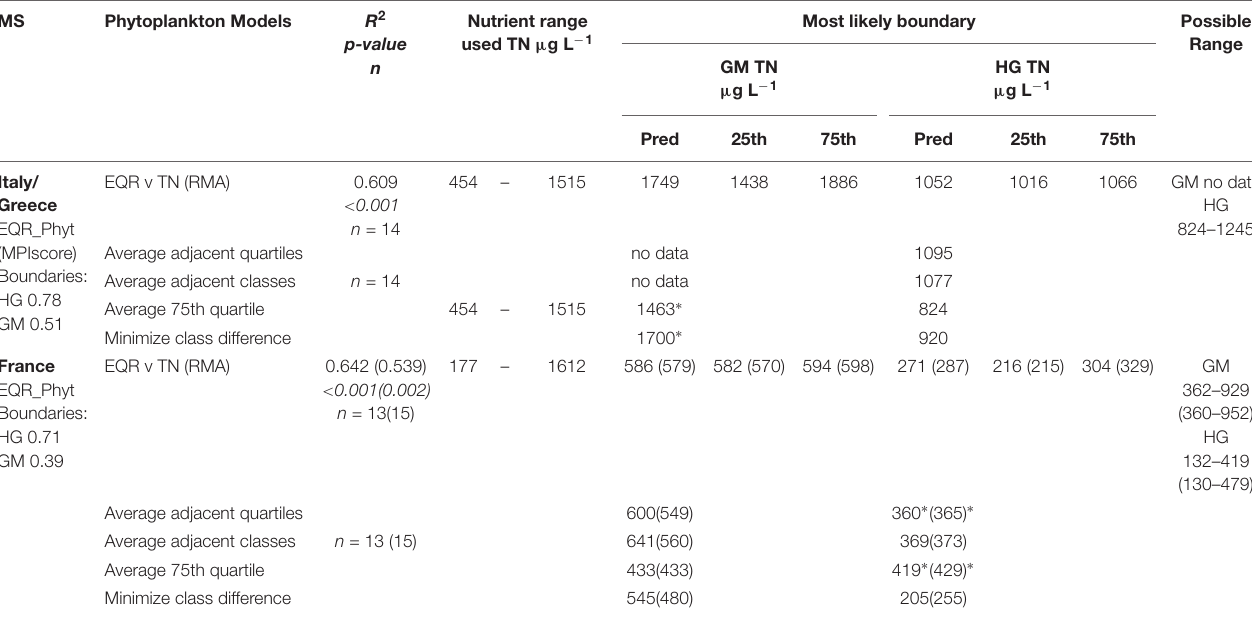
TABLE 3 | Summary of predicted values of nutrient concentration at the Good/Moderate (GM) and High/Good (HG) boundaries of TN ( µ g L − 1 ), per countries (IT/GR, and FR), within Mediterranean TRW common type polyhaline coastal lagoons (TRWMEDpolyCL), obtained by regression and categorical